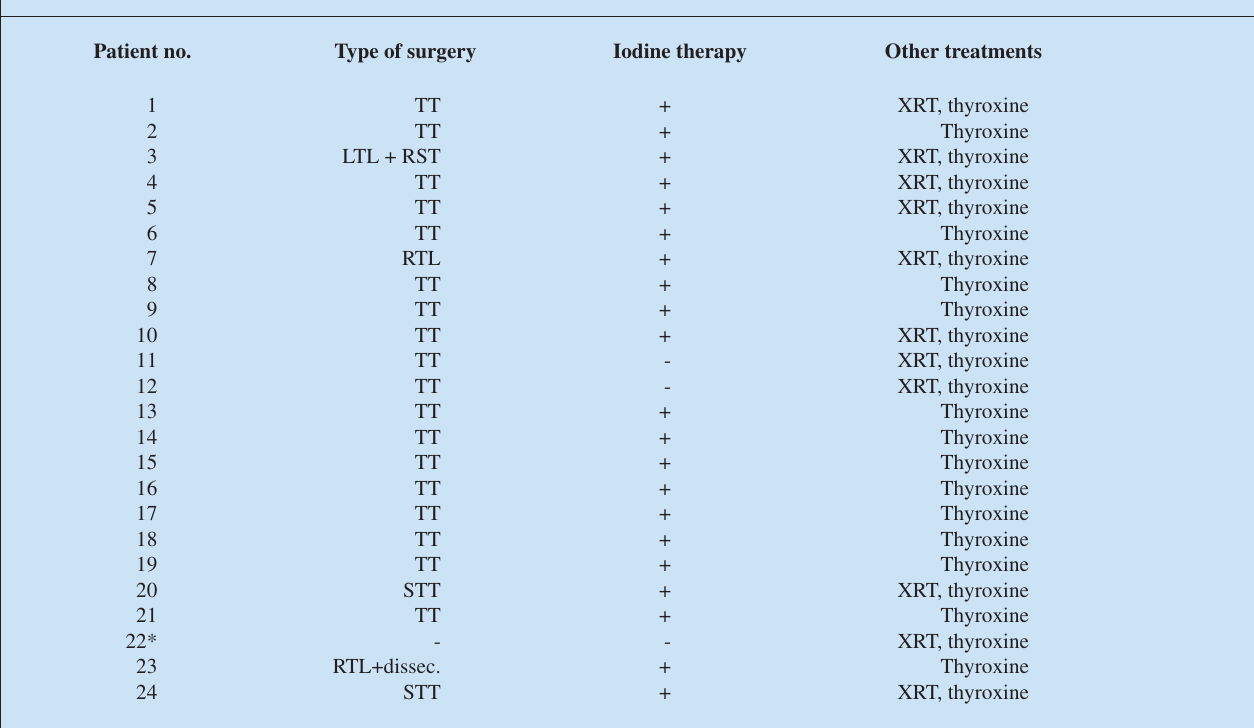
Table II. Different treatment